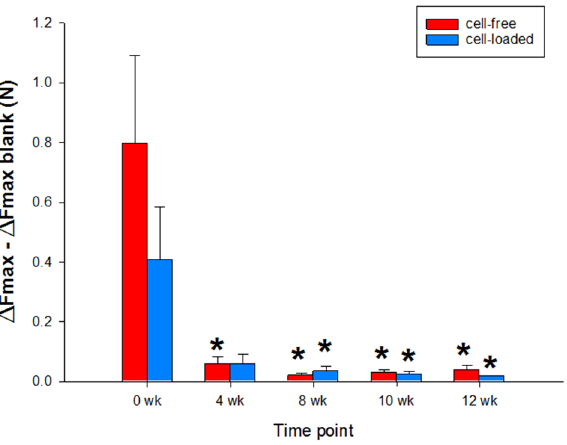
Figure 8. Biomechanical push-out analyses of cartilage/PGA hybrids (cell-free or cell-loaded). Means +/ − SEM; symbols show p ≤ 0.05 versus * 0 weeks.